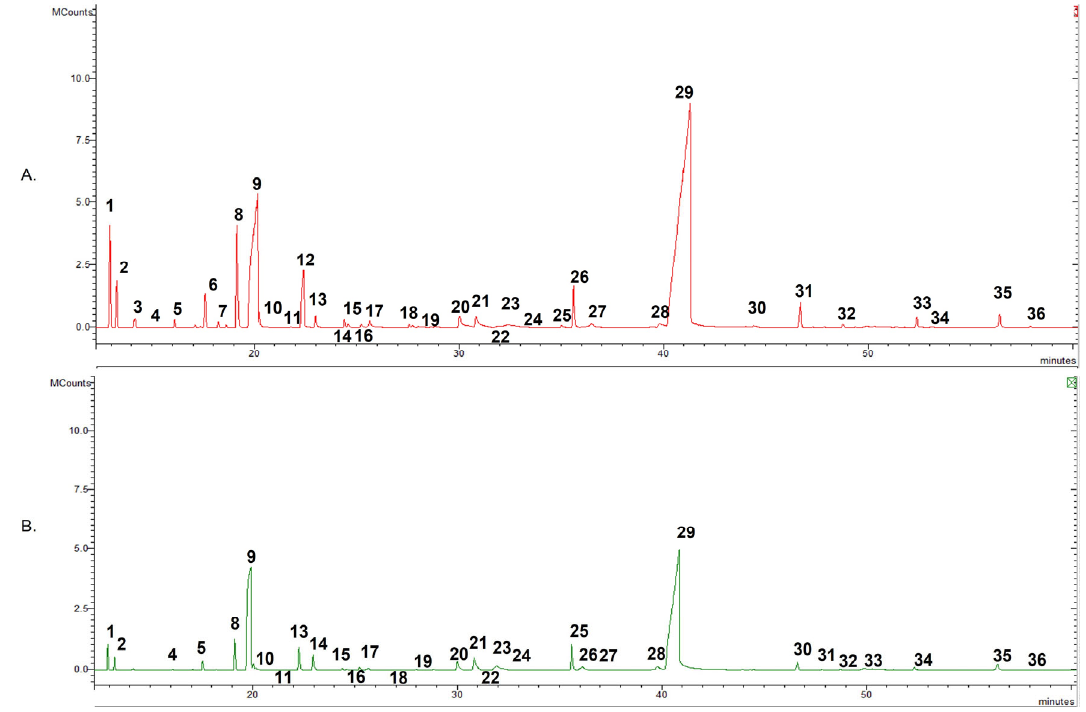
Figure 1. The gas chromatography (GC) chromatograms of O. heracleoticum essential oils: (A) OHR; (B) OHW. The numbers in the chromatograms indicate the compounds reported in Table 1.